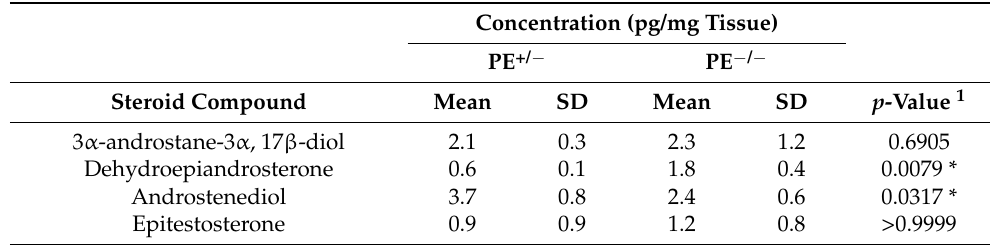
Table 2. Intratesticular steroids in adult PE +/ − and PE − / − mice.